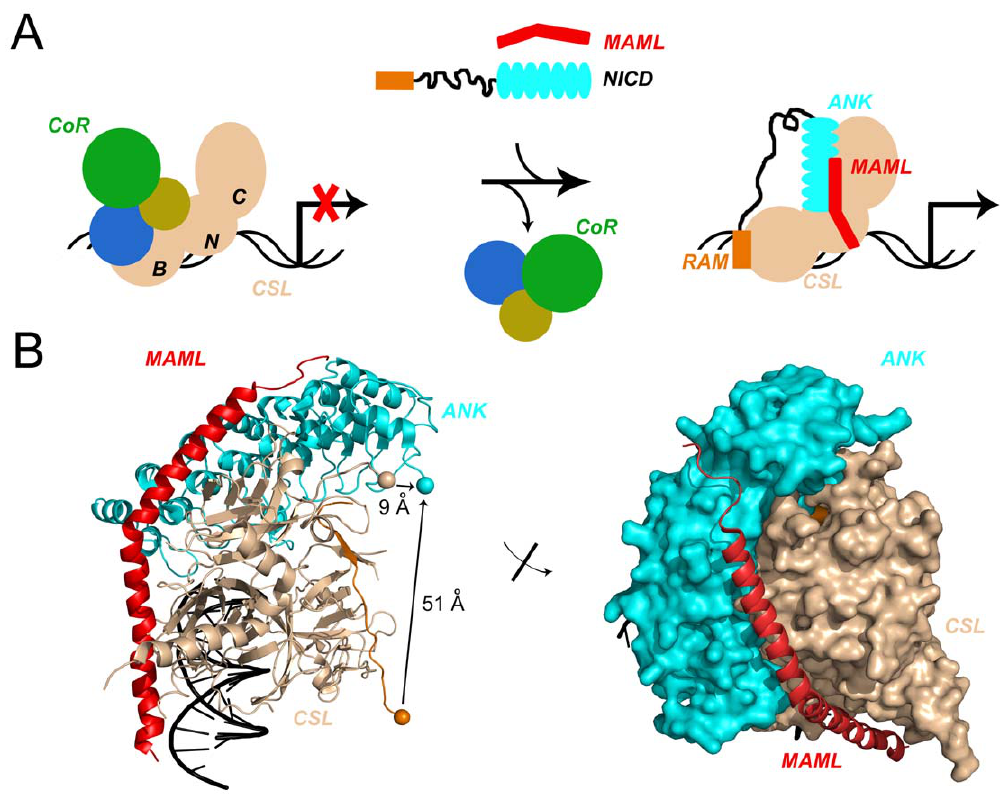
Figure 1. Switching on/off Notch signaling through CSL:NICD interaction. A). In the absence of active Notch signaling, the three-domain transcription factor CSL acts as a transcriptional repressor through interactions with a variety of co-repressor proteins and HDAC. The three domains of CSL are abbreviated N, B, and C for the NTD, BTD, and CTD, respectively. Bivalent binding between NICD and CSL (BTD:RAM and CTD:ANK) is believed to be coupled to co-repressor displacement, allowing for the recruitment of the co-activator protein MAML, resulting in active transcription of downstream target genes. B). Left, Ribbon diagram of the active ternary complex. The arrow highlights a separation of 51 A˚ between the C- terminus of RAM (orange sphere) and the N-terminus of ANK (cyan sphere). In the crystal structure, the C-terminus of CSL (wheat sphere) and the N- terminus of ANK (cyan sphere) are separated by 9 A˚. Right, Surface representation of the active ternary complex (CSL:NICD:MAML; PDB code 2FO1) shows MAML (red) binding at the interface between the CTD of CSL (wheat) and the ANK domain (cyan) of NICD. Molecular representations were generated using PyMOL [49].